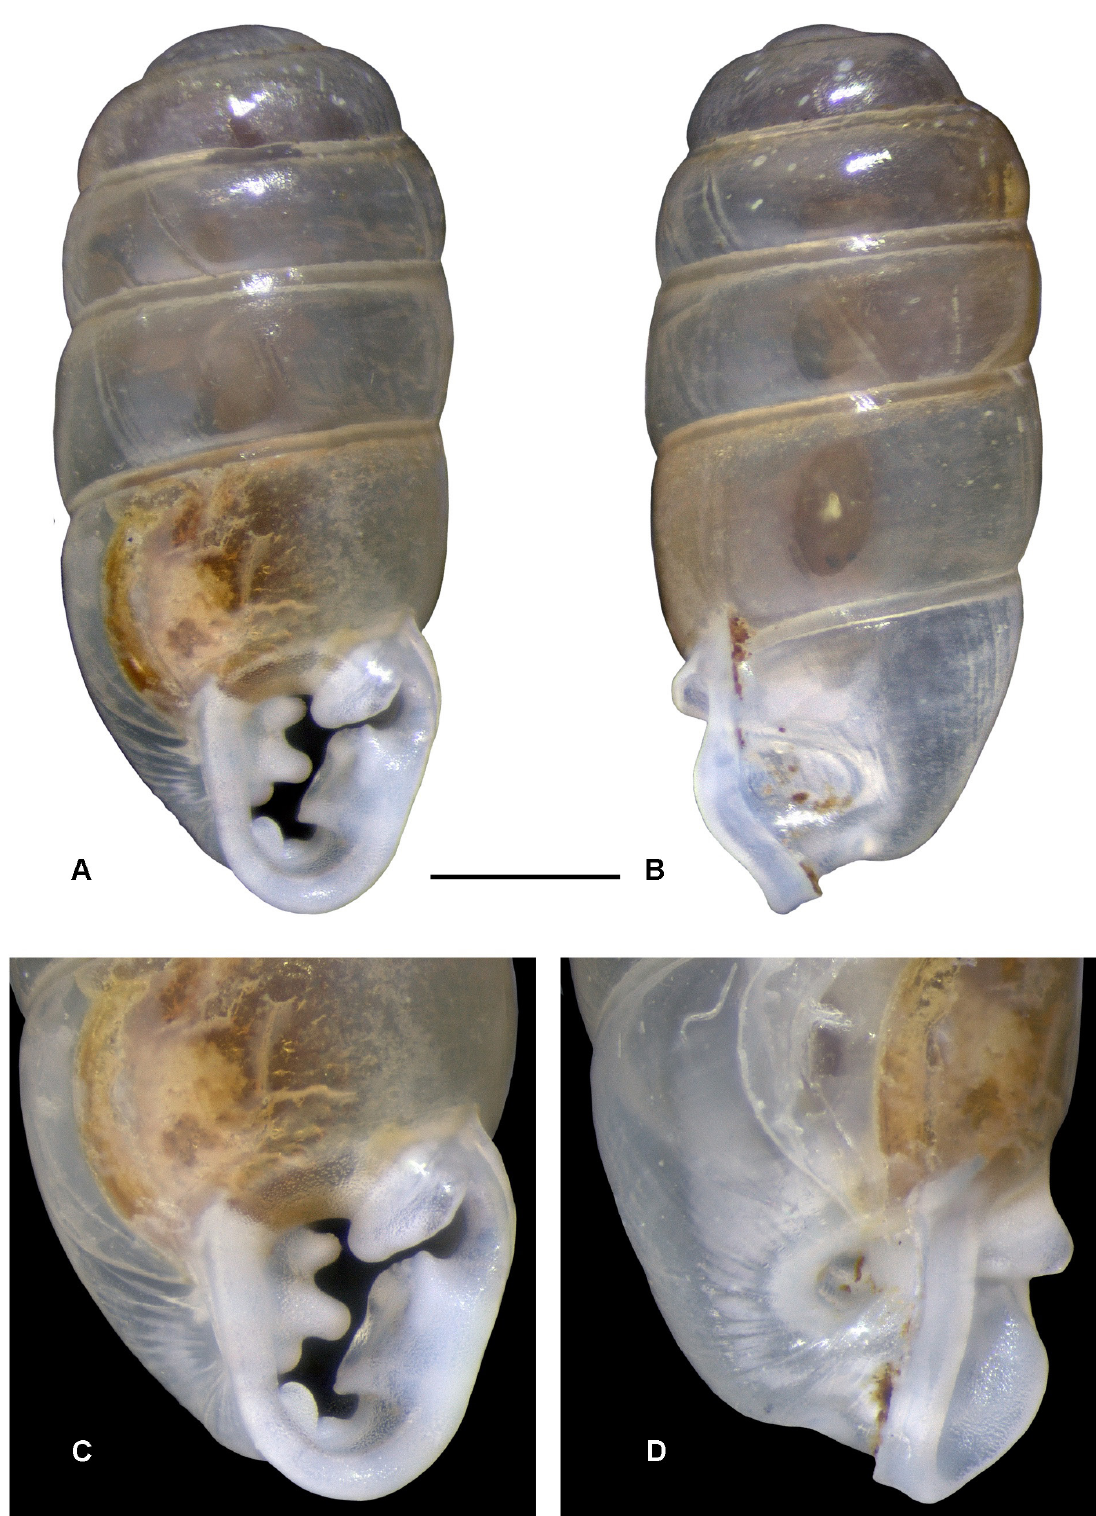
Fig. 1. Gulella kenbrowni sp. nov., holotype (NMSA P1678/T4524), length 2.20 mm, width 0.95 mm. A . Aperture view. B . Side view. C . Oblique view into aperture. D . Oblique view of base showing umbilicus. Scale bar = 0.5